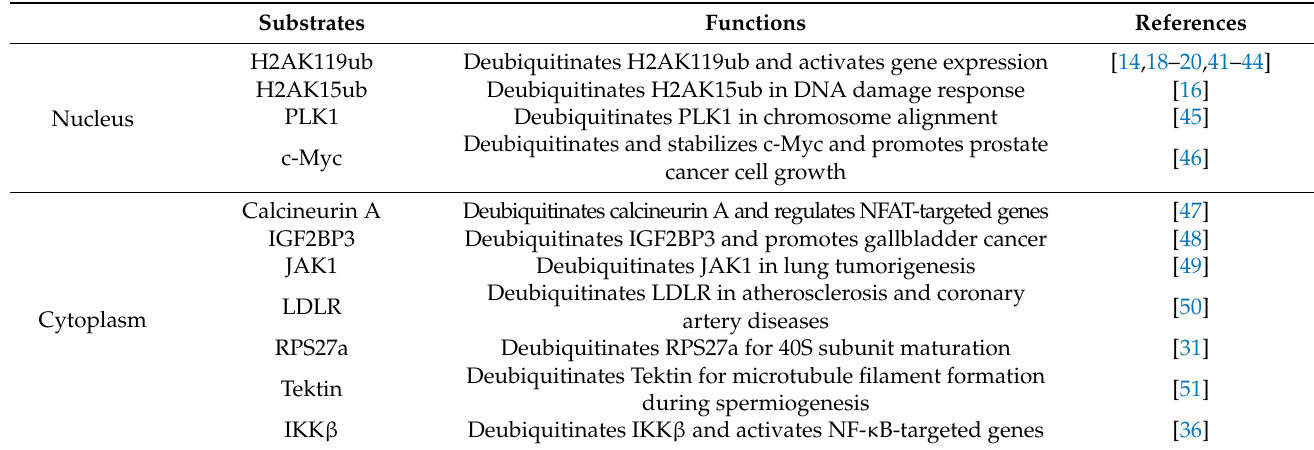
Table 1. Summary of the substrates and functions of